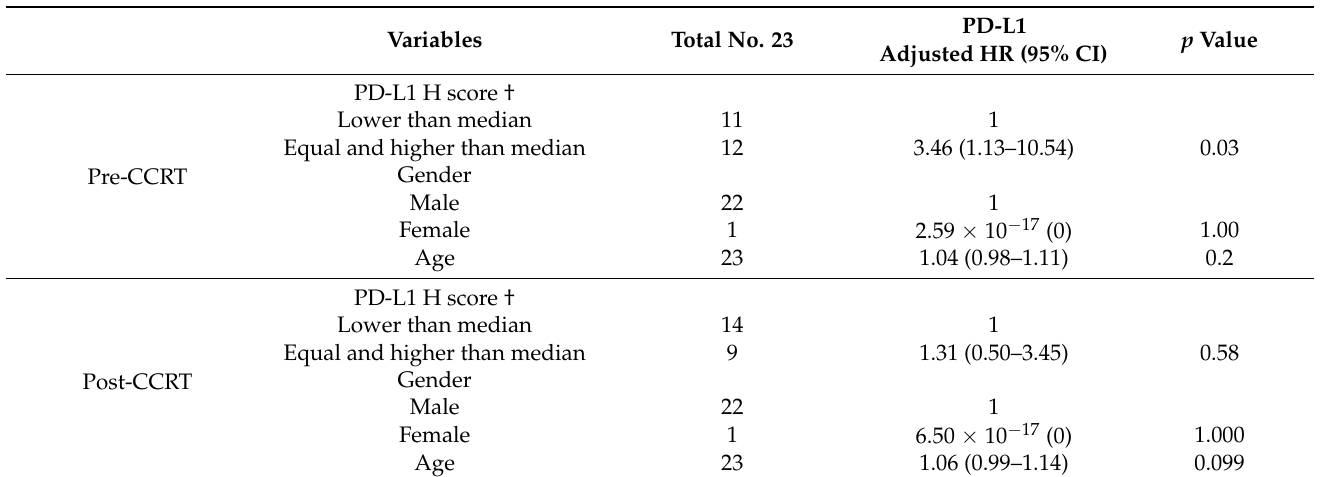
Table 3. Multivariate analysis of factors associated with overall survival in the 23 ESCC patients with paired specimens before CCRT by median of PD L1